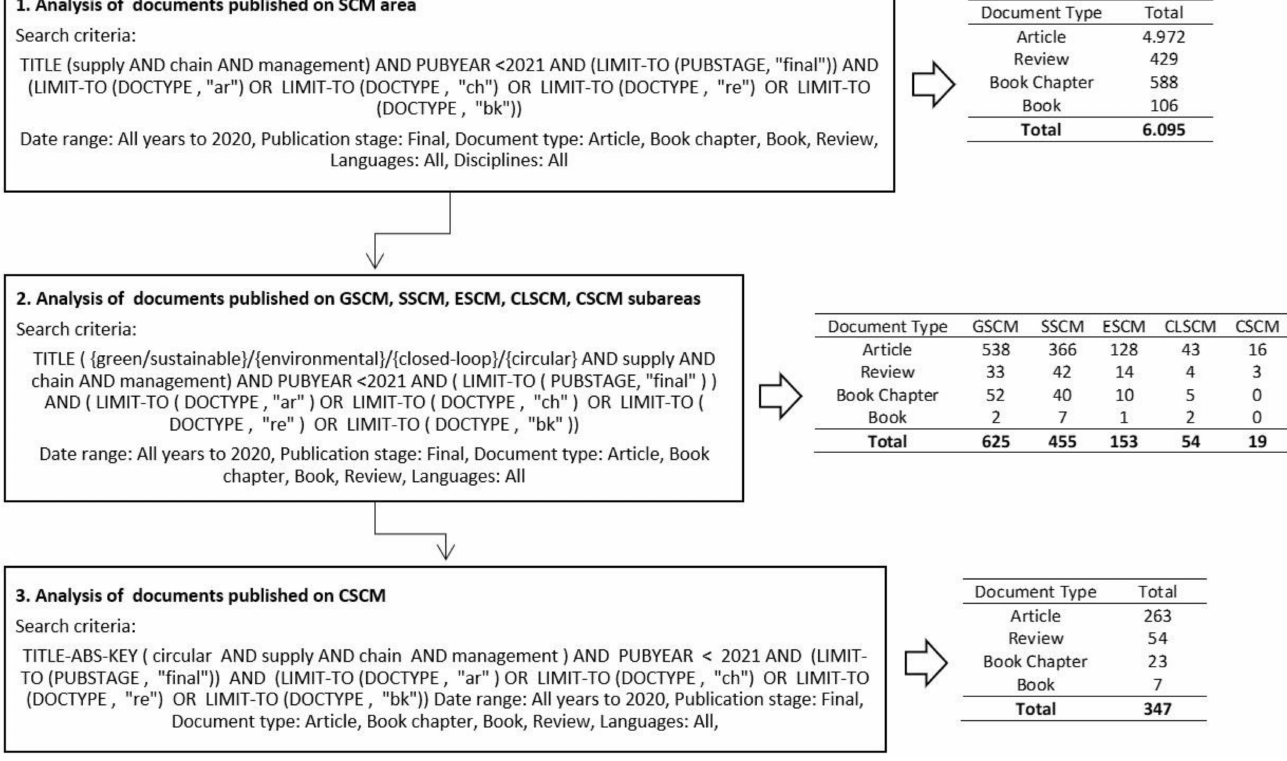
Figure 2. The main stages of the applied methodology. Search criteria and